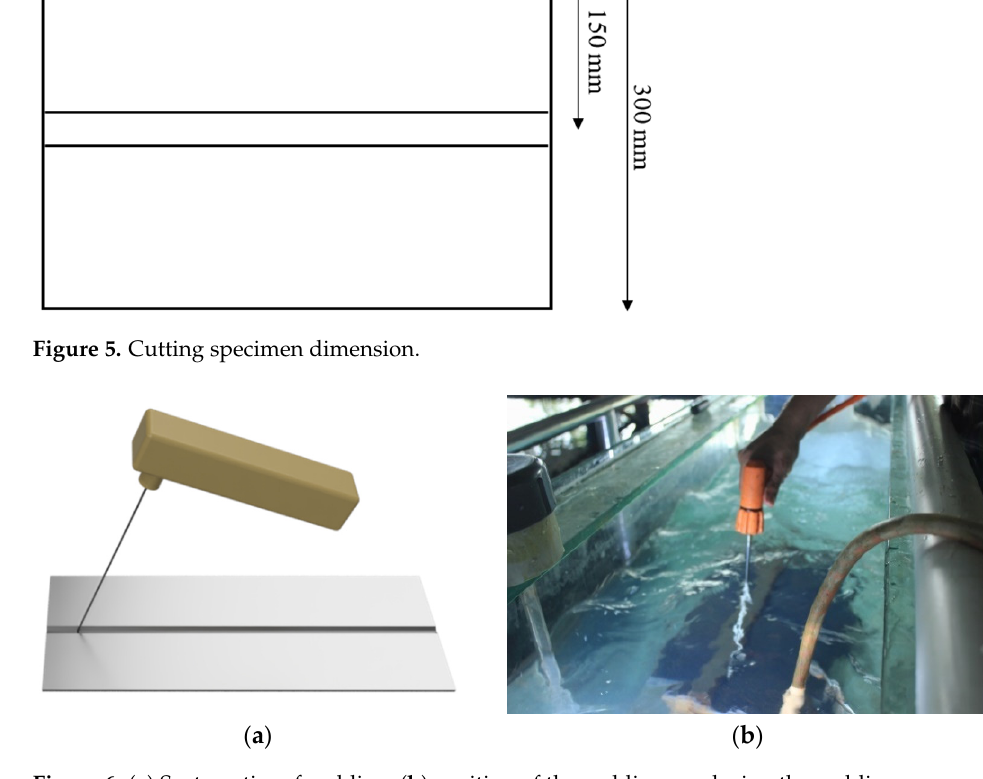
Figure 6. ( a ) Systematics of welding, ( b ) position of the welding arc during the welding process.